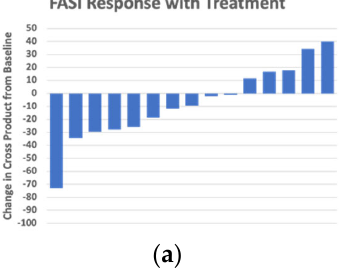
Figure 2. Longitudinal analysis of 15 treated/untreated subjects analyzed at paired time points over an average follow ‐ up time of 18.5 (±6.5) months, with each bar representing individual patients. Decrease in the FASI size with treatment ( a ) compared to without treatment ( b ) did not reach statistical significance. In the treated patients, there was a significant difference between the treated LGG ( c ) and treated FASI ( a